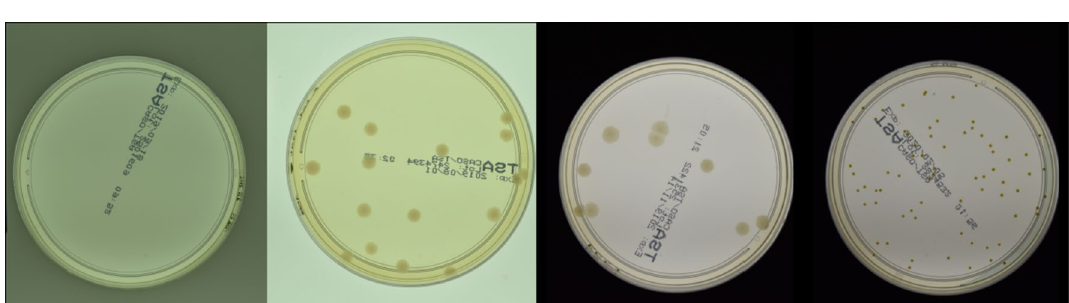
Figure 2. Exemplary images of Petri dish from the higher-resolution subset of the AGAR dataset that was used during the numerical experiments. From the left: empty dish with no colonies, dish containing 16 colonies of B. subtilis , dish containing 9 colonies of E. coli , and dish containing 72 colonies of S. aureus . Samples differ in numbers of colonies, types of microbial species cultured, and image acquisition setups—detailed information can be found in Supplementary Material for Majchrowska et al. 23